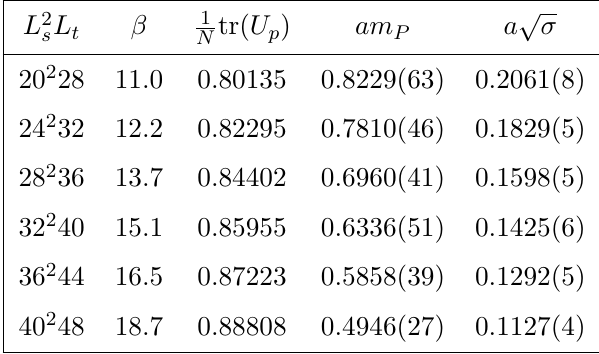
Table 12 . SO(4) average plaquette values, (cid:13)ux loop masses, and string